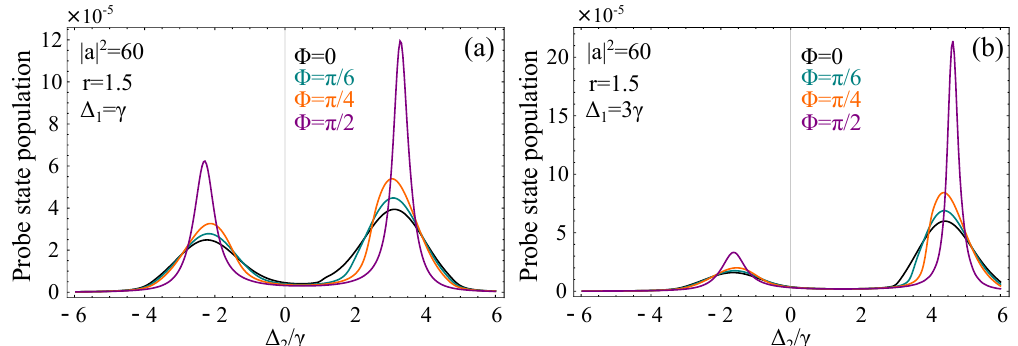
Figure 6. ( a ) Population of the probe state | b (cid:105) as a function of ∆ 2 for various angles Φ . The squeezed field is detuned from resonance with the | g (cid:105) ↔ | a (cid:105) transition by ∆ 1 = γ . ( b ) Population of the probe state | b (cid:105) as a function of ∆ 2 for various angles Φ . The squeezed field is detuned from resonance with the | g (cid:105) ↔ | a (cid:105) transition by ∆ 1 = 3 γ . In both panels, | a | 2 = 60, T = 30 γ − 1 , g 1 = 0.7 γ , and r = 1.5. Black lines: Φ = 0, teal lines: Φ = π /6, orange lines: Φ = π /4, and purple lines: Φ = π